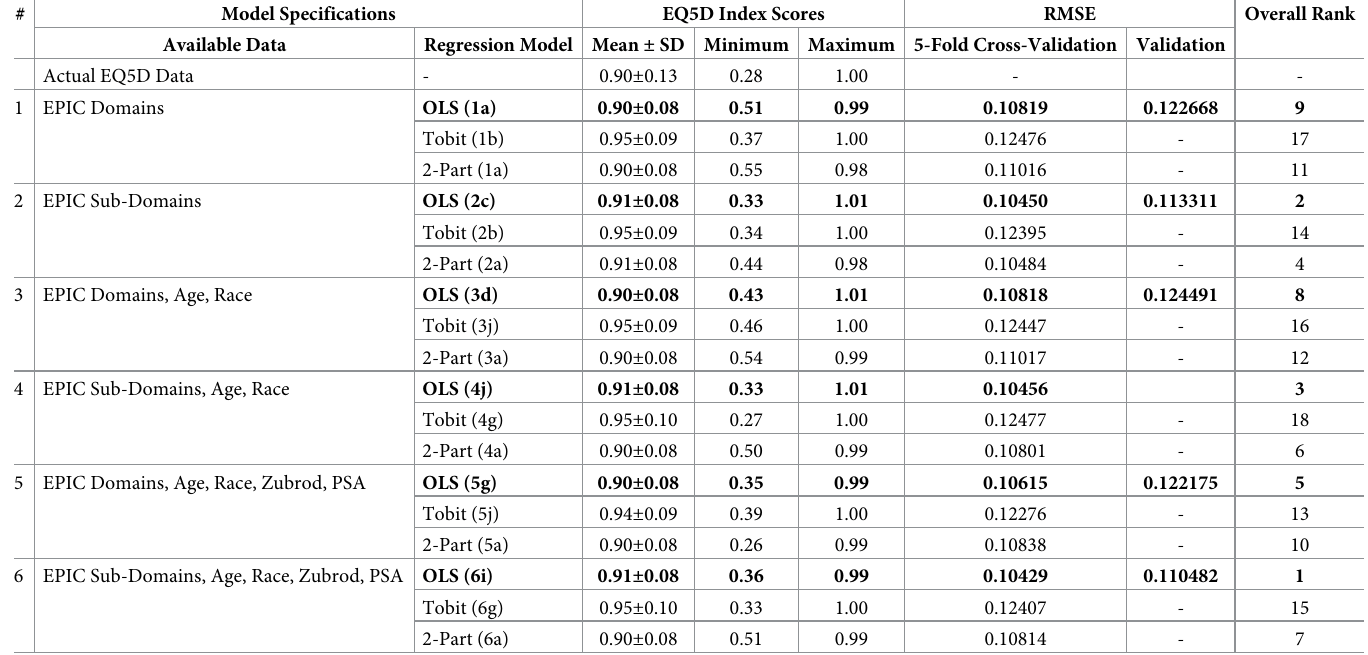
Table 3. Performance of full models in internal (5-fold cross-validation) and validation sets.